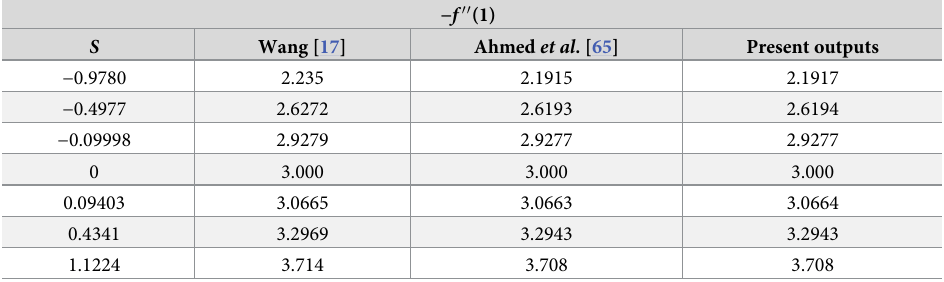
Table 1. Numerical outputs of − f 00 (1) for S when λ 1 !1 , Da !1 , De = N = 0 and Le = Pr =